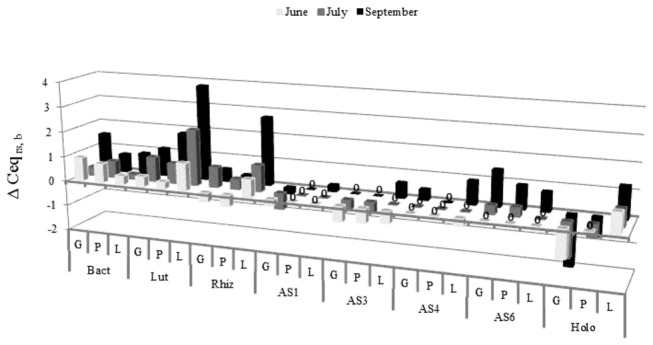
Effects of grass, potato and leek rhizospheres on abundances of total bacteria, Luteolibacter and Candidatus genus Rhizospheria and of subdivisions 1, 3, 4, 6 acidobacteria and holophaga (expressed as Δ Ceq rs, b values, i.e. log cell equivalent numbers from bulk soil subtracted from those from corresponding rhizospheres).G, P, L: Respectively, grass, potato, leek; 0: Δ Ceq rs, b value is zero.Bact, total bacteria; Lut, Luteolibacter; Rhiz, Candidatus genus Rhizospheria; AS1, AS3, AS4, AS6, respectively, subdivision 1, 3, 4, 6 acidobacteria; Holo, holophaga.